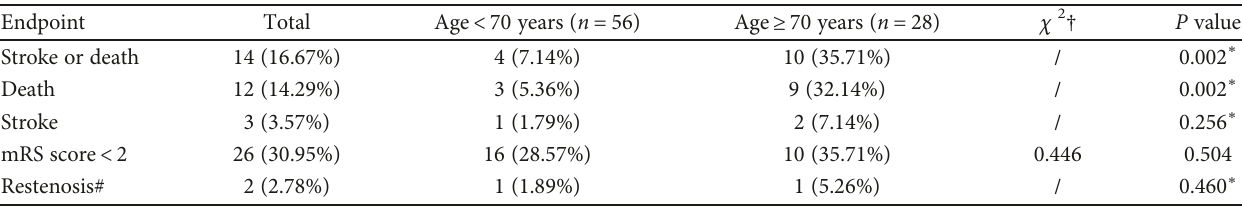
Table 2: Clinical endpoints of carotid artery